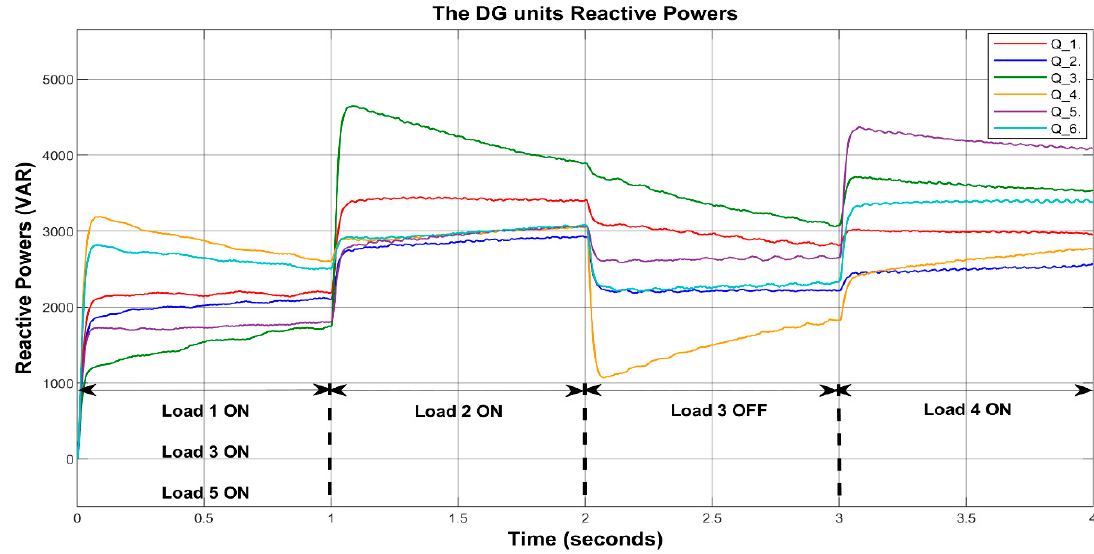
Figure 11. The DG units’ reactive powers for Case 1.